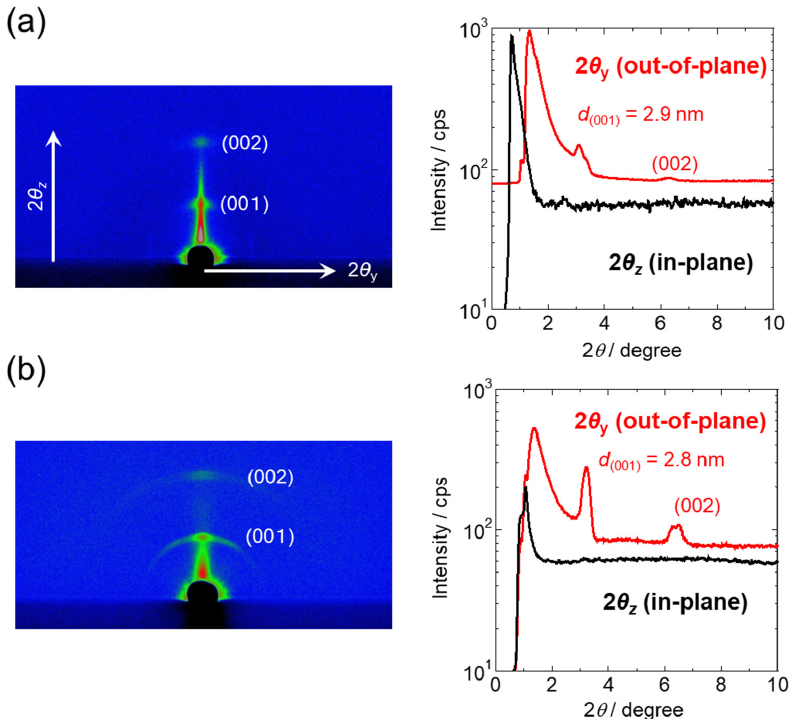
Figure 1. GI-SAXS data of PAz films with thicknesses of 100 nm ( a ) and 400 nm ( b ). In each part, left and right figures display 2D GI-SAXS patterns and 1D intensity profiles taken from the 2D data, respectively. In the left profiles, red and black data show the out-of-plane and in-plane directions, respectively.